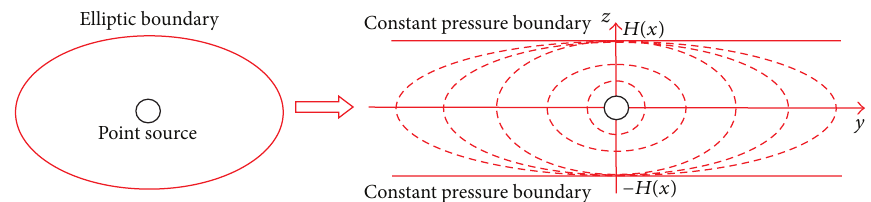
Figure 2: Method of displacement between two similar flow modes.